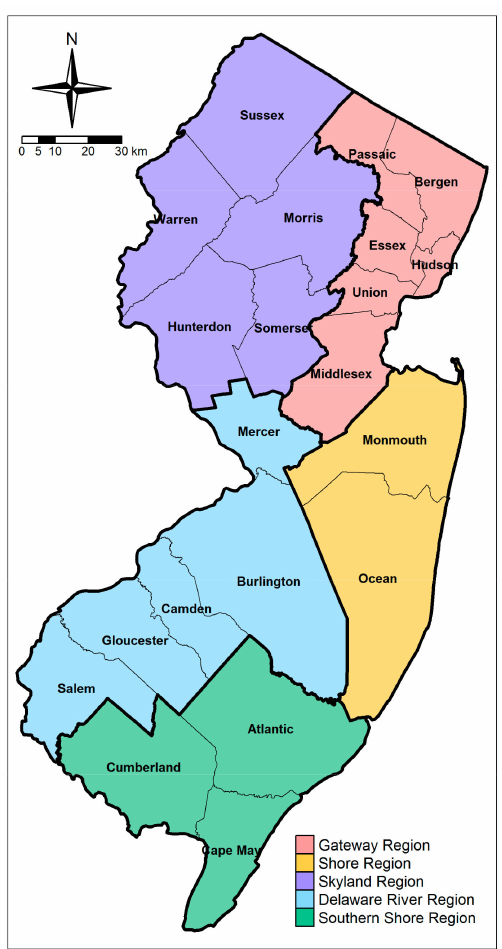
Figure 2. The 21 Counties and the five geographical regions identified based on similarities of exposure-relevant factors across the State of New